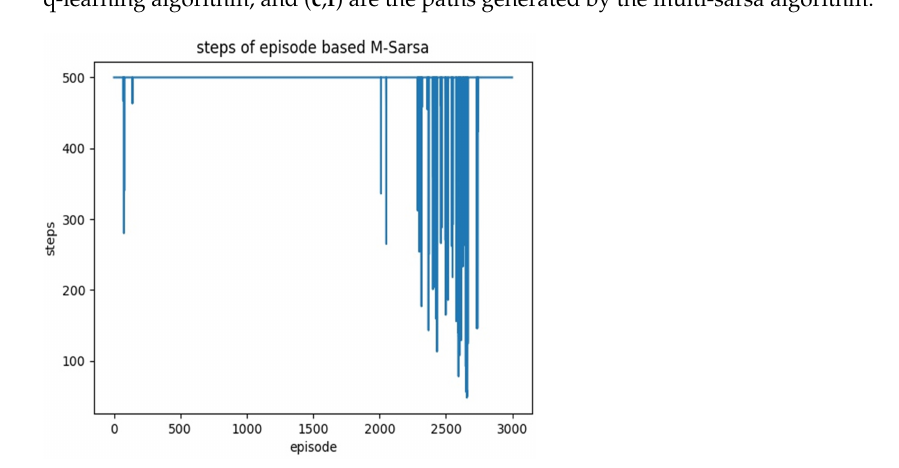
Figure 13. In the same environment, ( a – c ) are the planning results of the SARSA algorithm, Q-Learning, and the algorithm proposed in this paper, respectively. The colored part is a topological area, and one color corresponds to a topological area. The white dot is the selected representative topological node, the starting point is the upper left corner, and the end point is set in the lower right corner. ( a , d ) are the paths generated by sarsa algorithm, ( b , e ) are the paths generated by q-learning algorithm, and ( c , f ) are the paths generated by the multi-sarsa algorithm.